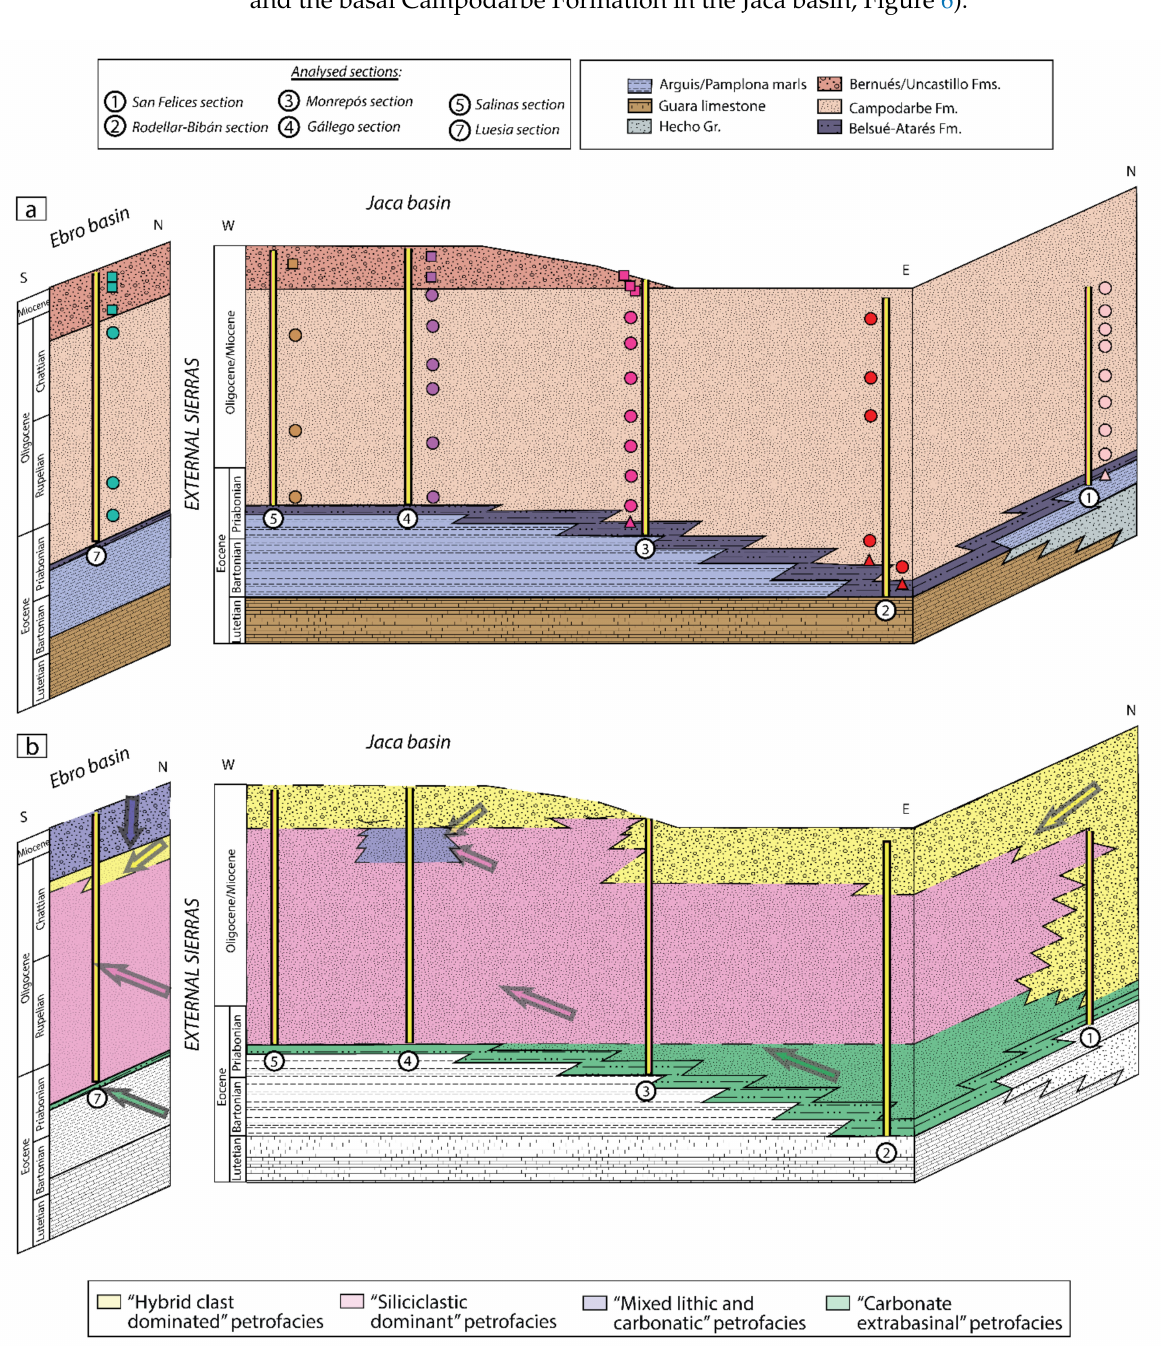
Figure 6. ( a ) General stratigraphic cross-section sketch with symbols representing the relative position of the analyzed samples presented in Figure 3, used here to understand the petrofacies scheme below. ( b ) Colored stratigraphic cross-section sketch in order to illustrate the distribution of the petrofacies laterally and through time. Yellow color corresponds to “hybrid clast-dominated” petrofacies, green color to “carbonate extrabasinal enriched” petrofacies, blue color to “mixed lithic and carbonatic” petrofacies, and pink color to “siliciclastic dominant” petrofacies. Colored arrows are used to facilitate reading of the provenance information. Dashed lines represent the boundaries between